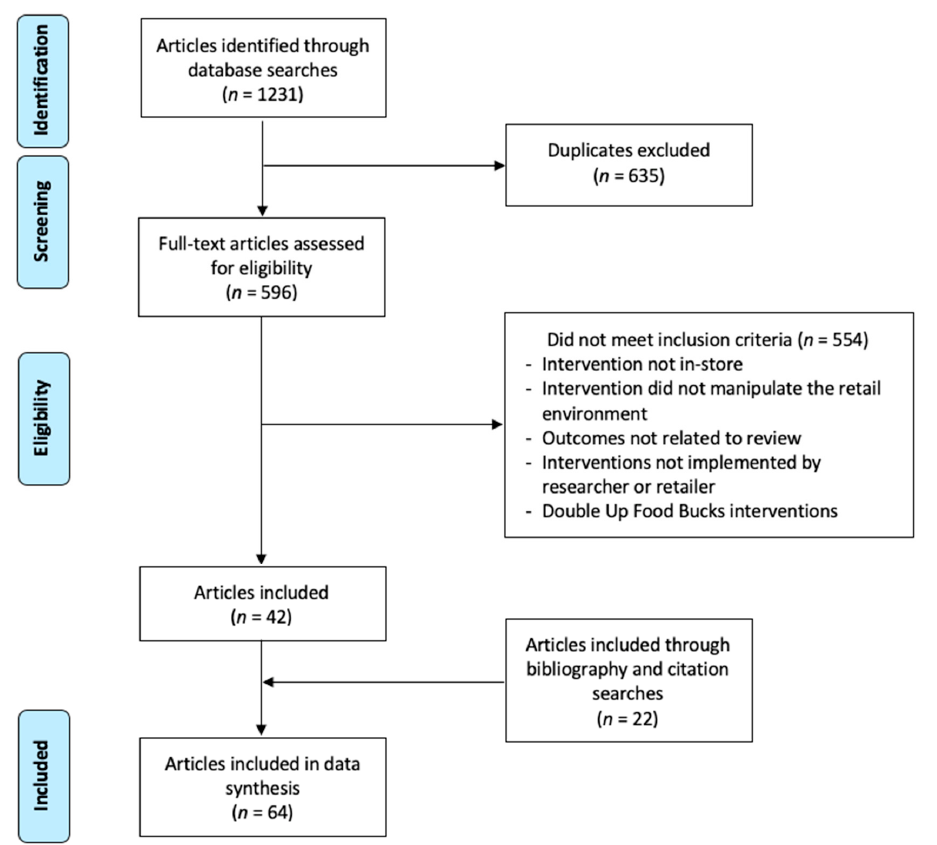
Figure 1. Article inclusion flow chart.